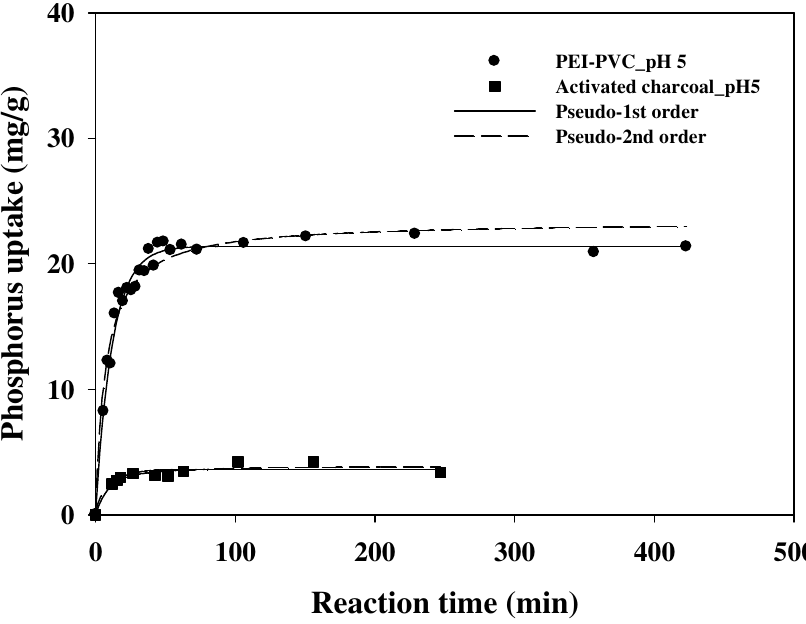
Figure 6. Phosphorus sorption kinetics of PEI-PVC and activated charcoal at pH 5.